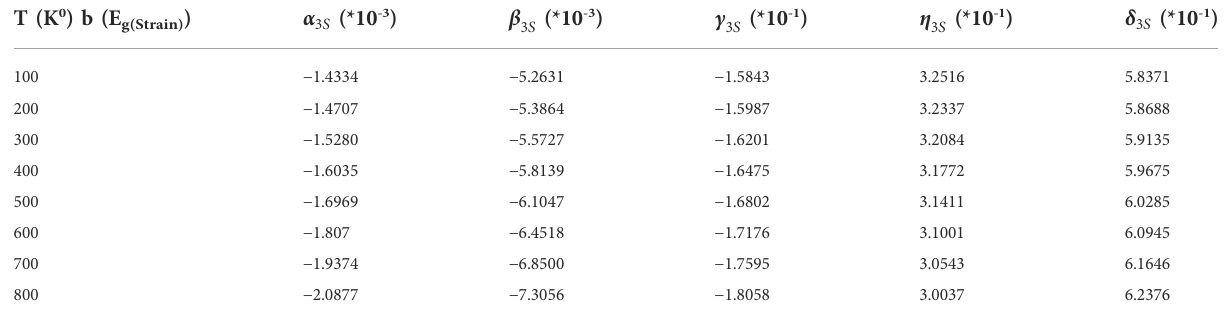
TABLE 4 Fitting parameters for “ b ” under the strained condition at different temperatures.